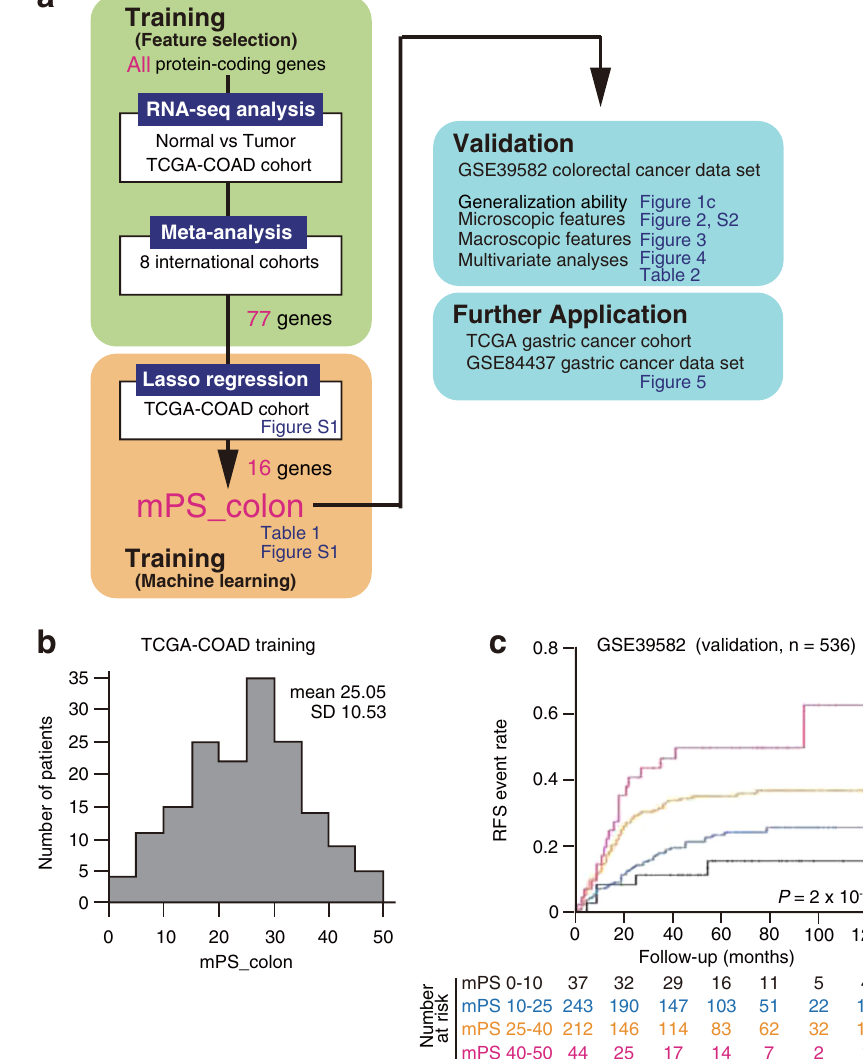
Fig. 1 mPS_colon provides a simple and robust estimation of prognosis for colorectal cancer (CRC) patients. a All genes were tested for their potential as prognostic genes with the use of nine independent multicenter data sets. Genes were fi ltered to identify differentially expressed genes between normal mucosa and CRC tissue with the use of the TCGA-COAD data set, and the identi fi ed genes were subjected to a meta-analysis with eight additional cohorts. A machine learning approach (lasso regression) then extracted 16 genes that are important for the prediction of relapse. The robustness of mPS_colon was demonstrated with various CRC subsets. Finally, we found that mPS_colon also estimates the prognosis of individuals with gastric cancer. b mPS_colon distribution in the TCGA-COAD training cohort. c Kaplan – Meier curves of relapse-free survival (RFS) for the GSE39582 CRC test cohort based on mPS_colon. The log-rank P value is